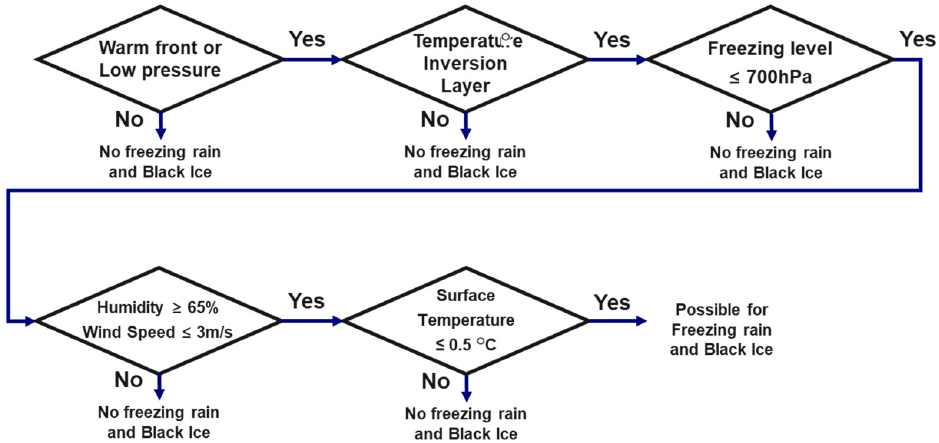
Figure 8. Black ice risk estimation model used in the study.